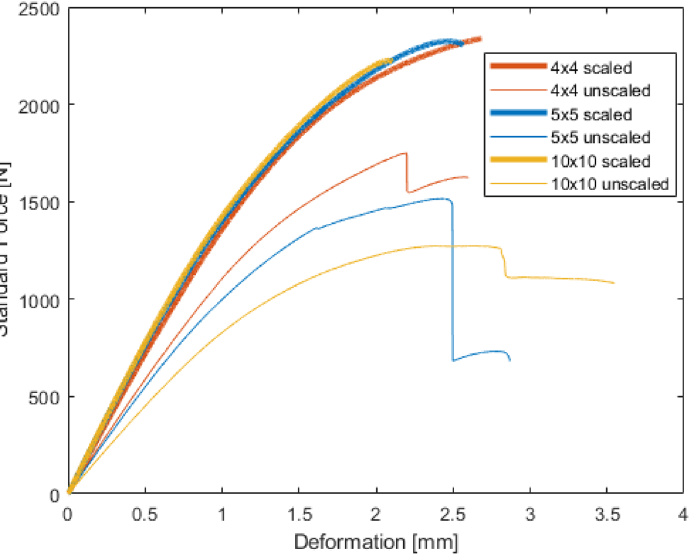
Figure 7. Results of the tensile